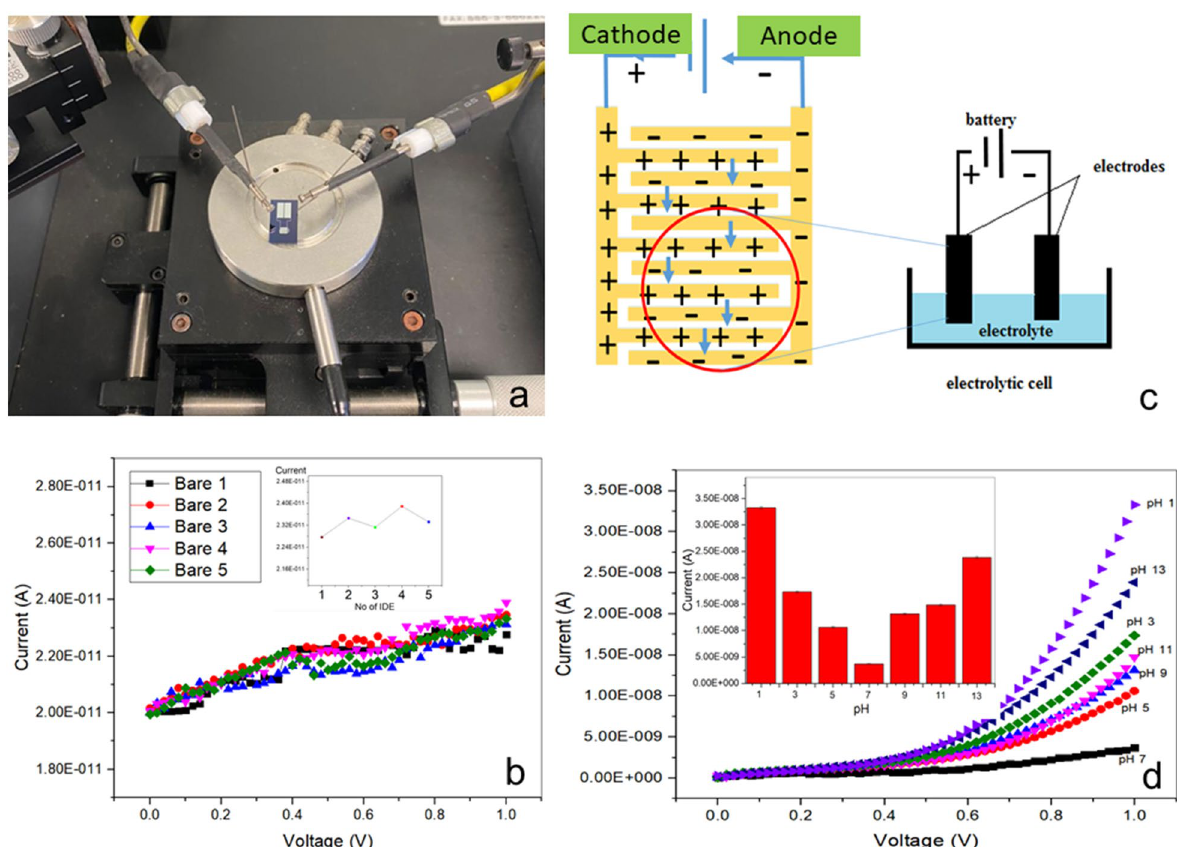
Figure 3. Electrical characterization measurements with a Source Meter Keithley 2450, using the Kick Start software. ( a ) Probe station with Al IDE biosensor. ( b ) I–V characteristics of bare Al IDE with Si substrate. The figure inset indicates the reproducibility using five bare Al IDEs. ( c ) Electrolysis is a procedure where an electric current is passed through a liquid to produce a chemical transition. The experiment was performed in an electrolytic system, an apparatus composed of positive and negative electrodes separated and immersed in a solution of positive and negative ions. In this case, the mechanism for transferring ions between Al IDE finger electrodes. ( d ) I–V measurements with different pH ionic solutions. The electrodes were tested in environments ranging from acidic (pH 1, 3, 5) to alkaline (pH 9, 11, 12). The figure inset indicates the difference in the current corresponding to each ionic solution and its respective